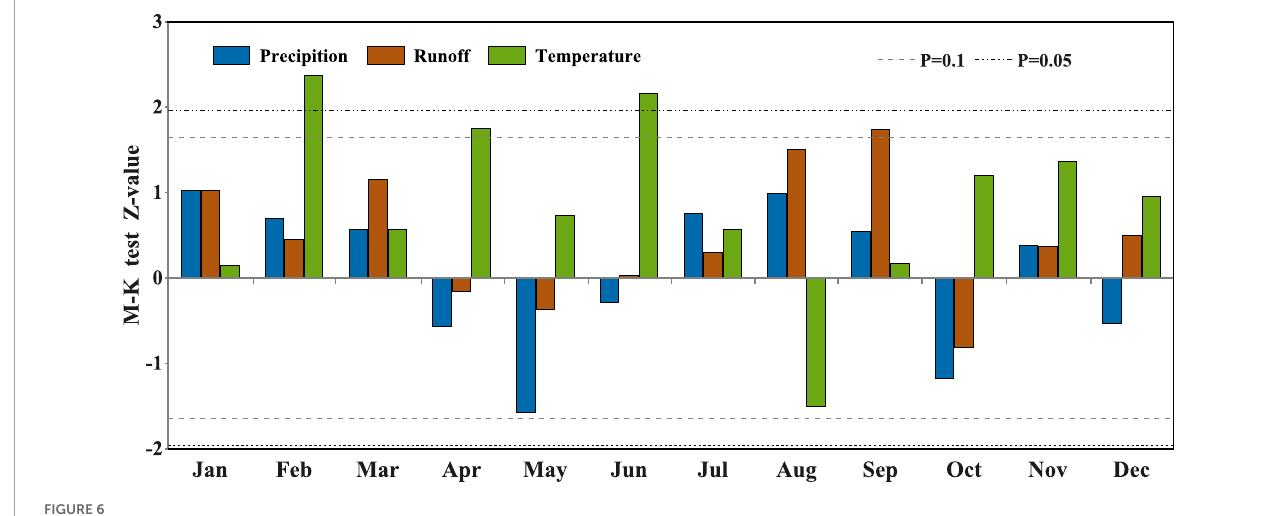
FIGURE6 Mann-Kendall (M-K) test results of monthly rainfall, runoff and temperature.